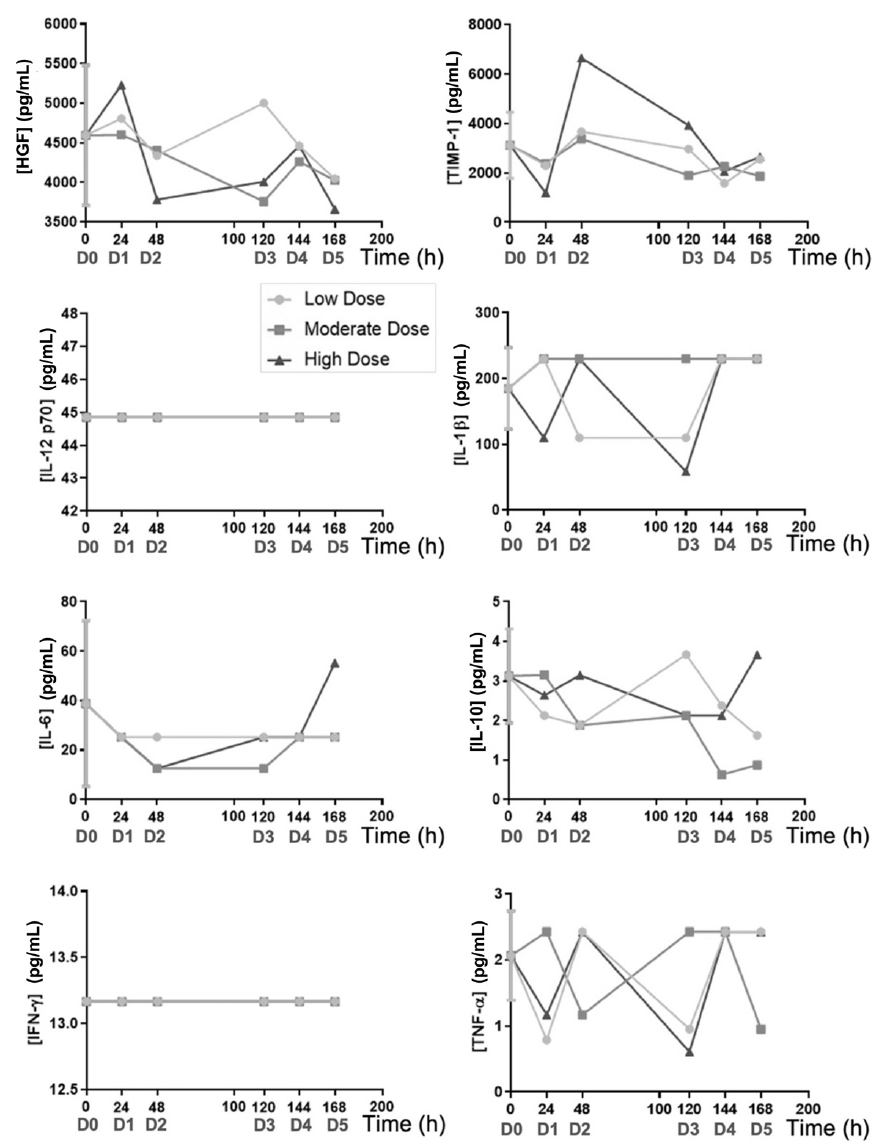
Figure 5. Analysis of murine cytokines. Blood samples were extracted from 8 out of 15 mice from day 0 (before treatment) and from each one of them at their respective experimental point (see Methodology). Afterwards, their sera were used to quantify the levels of human TNF- α , IL-6, IL-10, IL-1 β , IFN- γ , IL-1Ra, IL-12 p70, and HGF, by multiplex assays. D0–5 indicates the number of doses already administered to those mice at every time point. Time = 0 h is represented as the mean +/ − SD from eight samples. Supplementary information is available in Table S3: Values of murine cytokines analyzed by multiplex